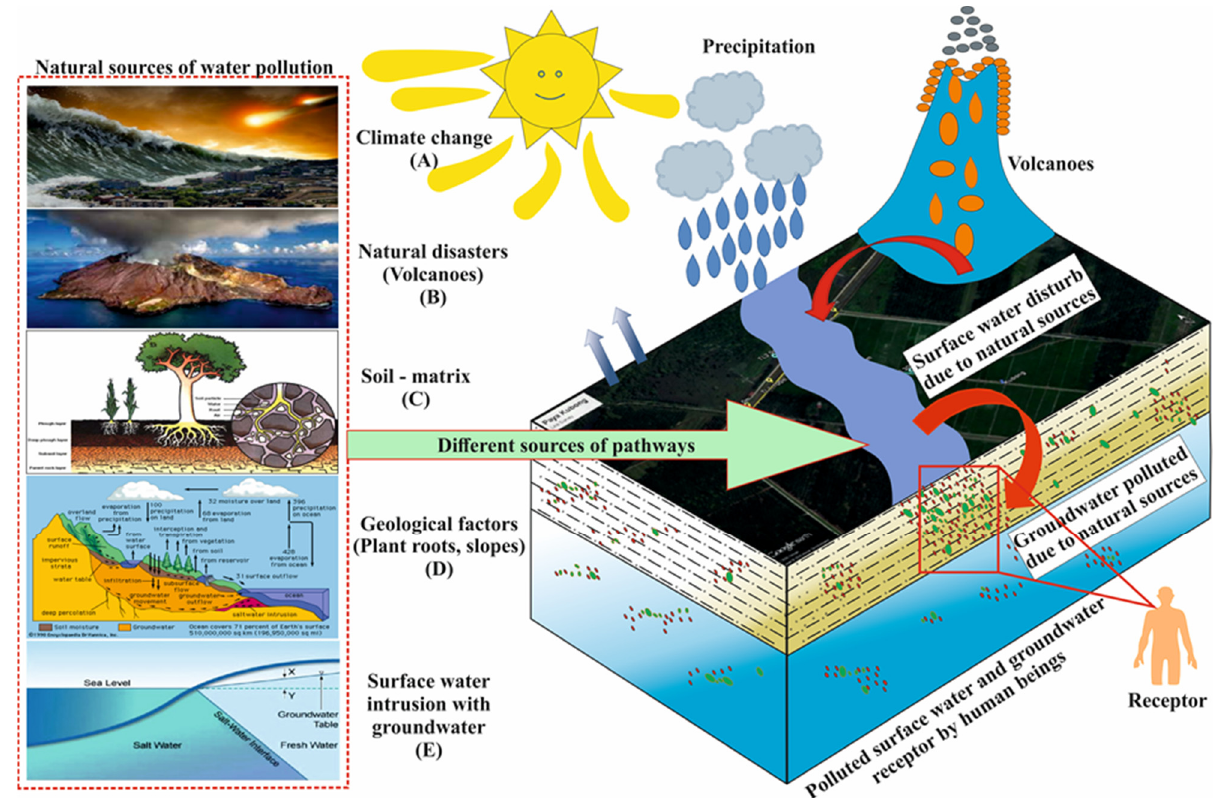
Figure 3. This diagram demonstrates the natural factors affecting the quality of surface water and groundwater, their pathways, and ( A ) climate change (Available online: https://flipboard.com/article/asteroid-tsunami-nasa-s-fear-of-250metre-city-killer-space-rock-striking-wate/f-fd71cce6b3